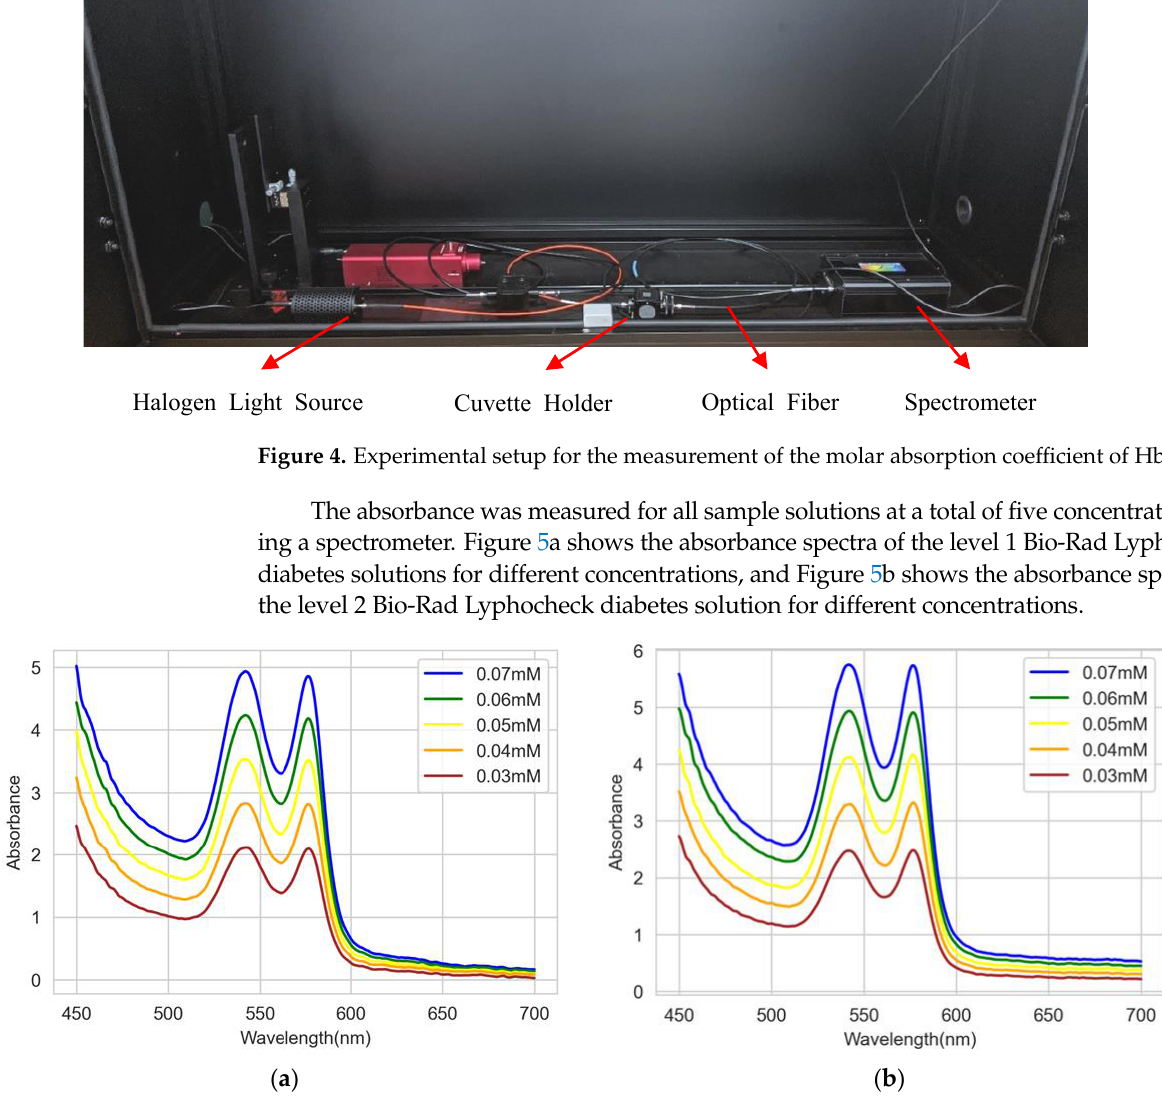
Figure 5. Absorbance spectra of Bio-Rad Lyphocheck diabetes solutions for different concentra- tions for ( a ) level 1 and ( b ) level 2.